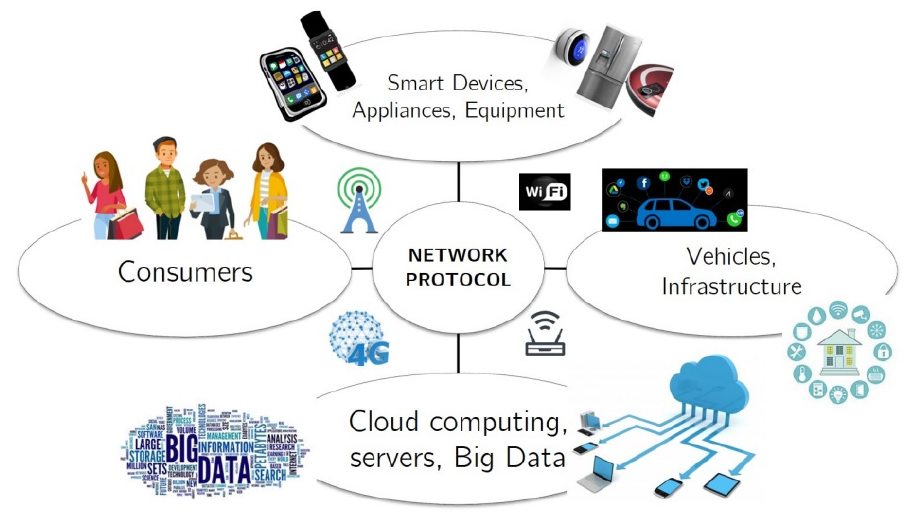
Figure 3. IoT Environment